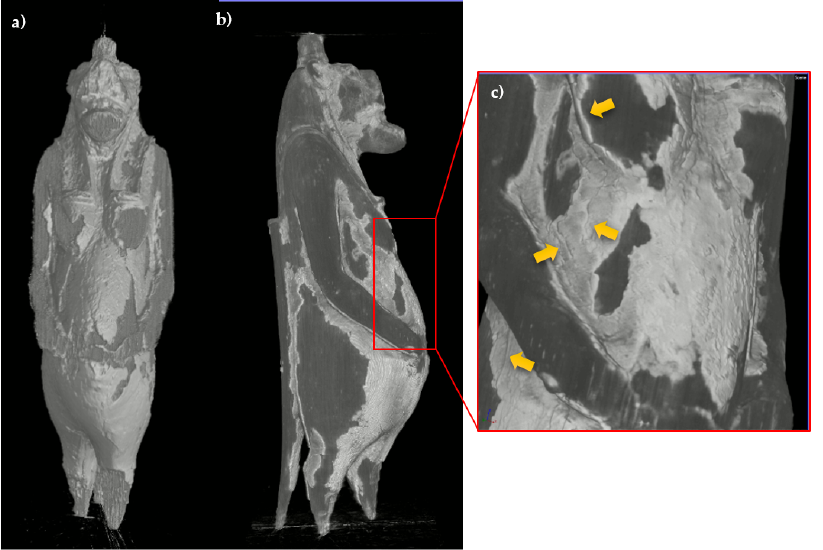
Figure 9. 3D model of the statuette with different surface render tools, (( a ), Scatter Gradient v1.2 tool), (( b ), Hardware render (scatter gradient) tool); enlargement of the body area in which the cracking is visible (yellow arrows) ( c ).